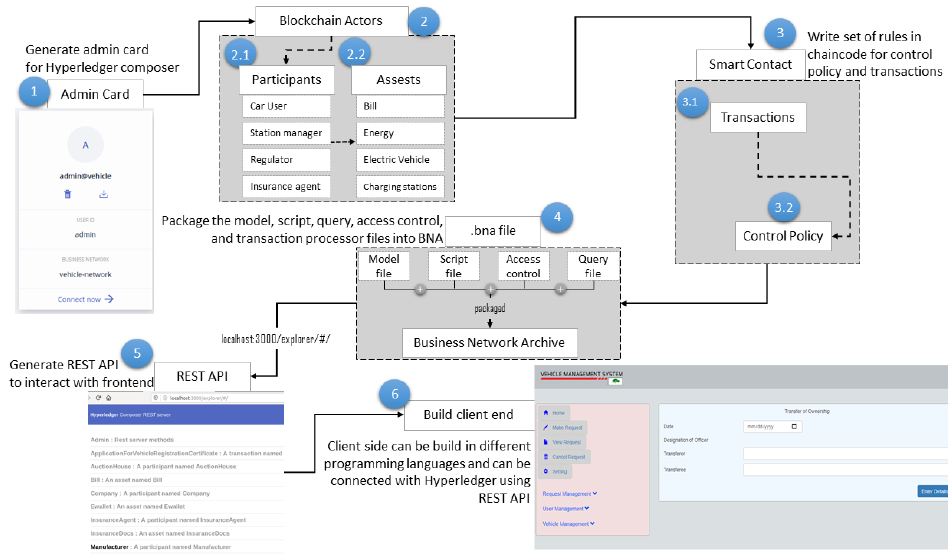
Figure 8. Process flow for private blockchain